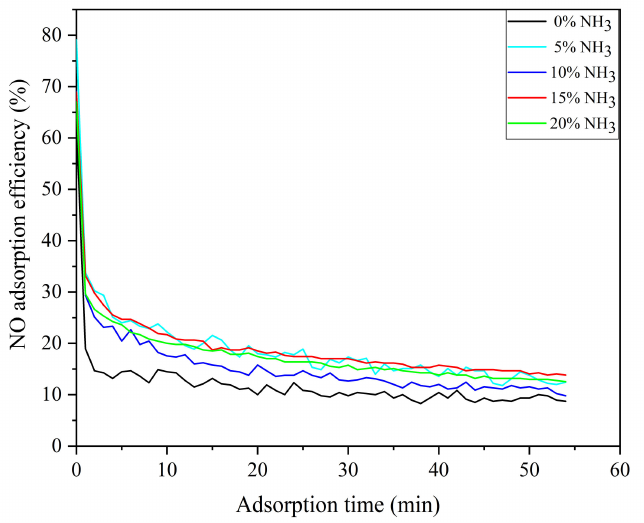
Figure 3. Effect of modified activated coke with different NH 3 concentrations on NO adsorp- tion